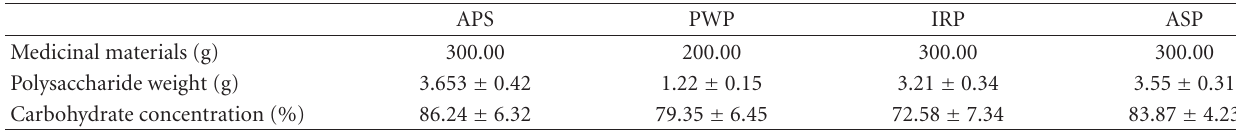
Table 2: Extraction of polysaccharides from four Chinese medicinal materials. Data represent means ± SD ( n = 3).